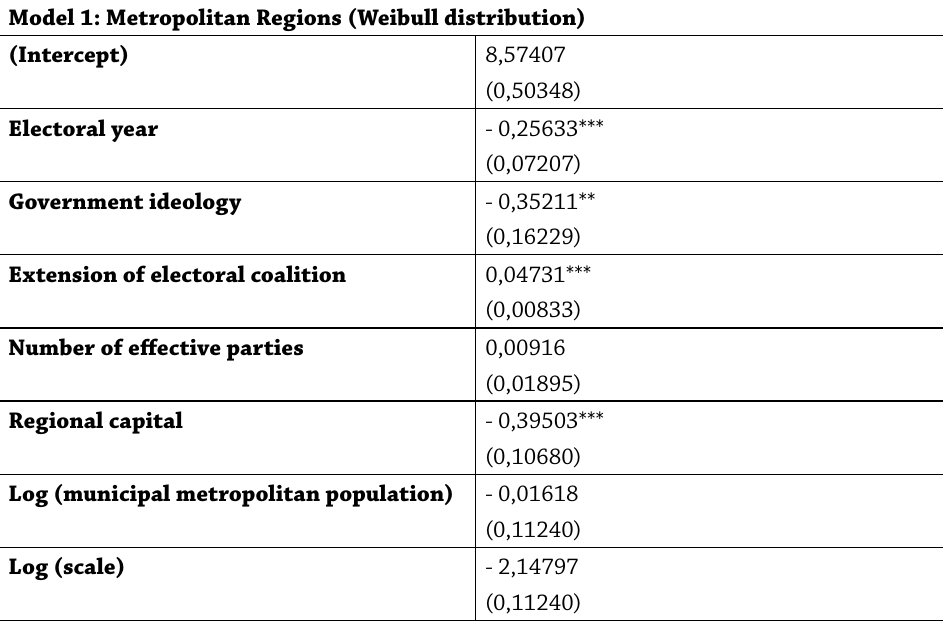
Table 1: Determinants of the Diffusion of Metropolitan Regions in Brazil (1991-2018) Model 1: Metropolitan Regions (Weibull